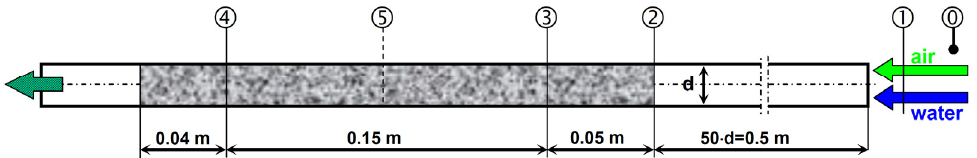
Figure 5. Locations of sections in the installation that play a role in determining pressure values. ( description in text ) .